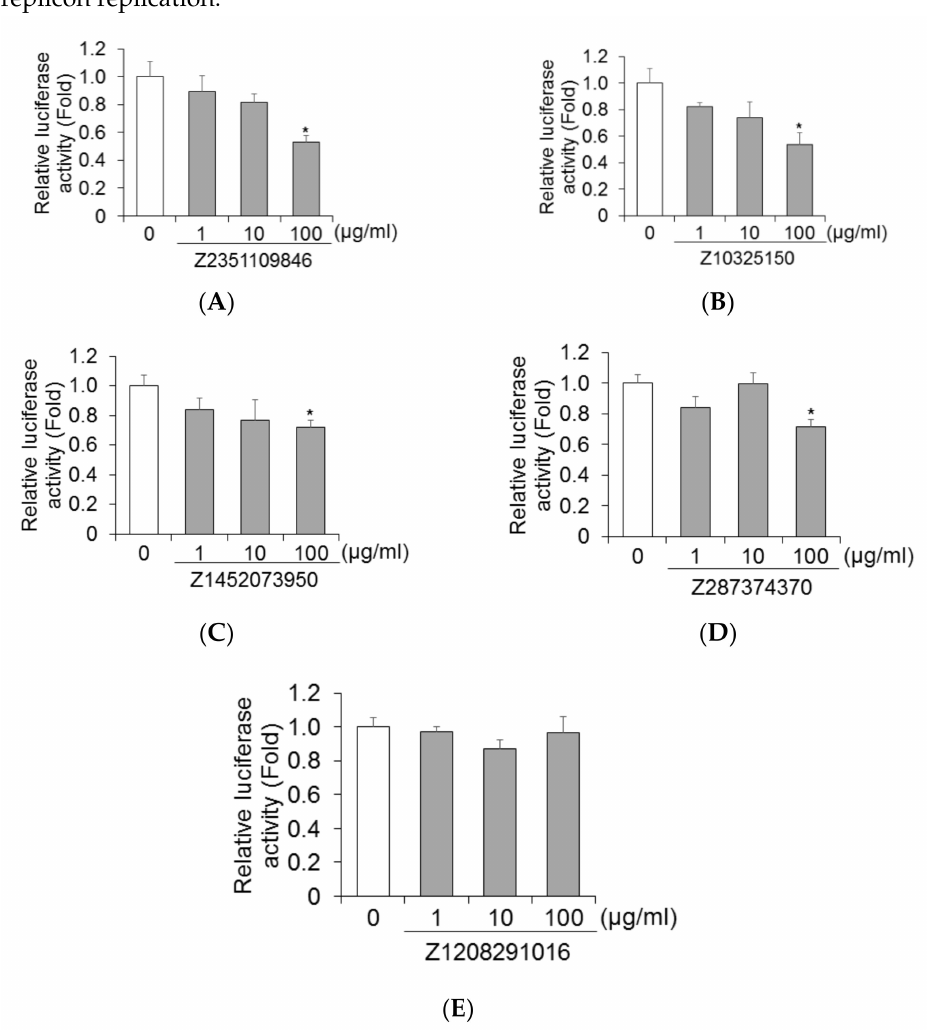
Figure 3. Z2351109846, Z10325150, Z1452073950, and Z287374370 inhibited HAV genotype IB